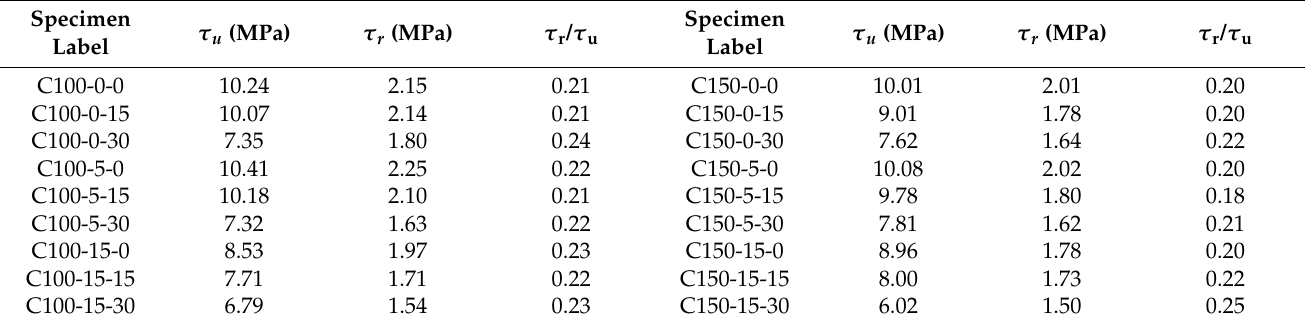
Table 10. The peak bond stress and residual bond